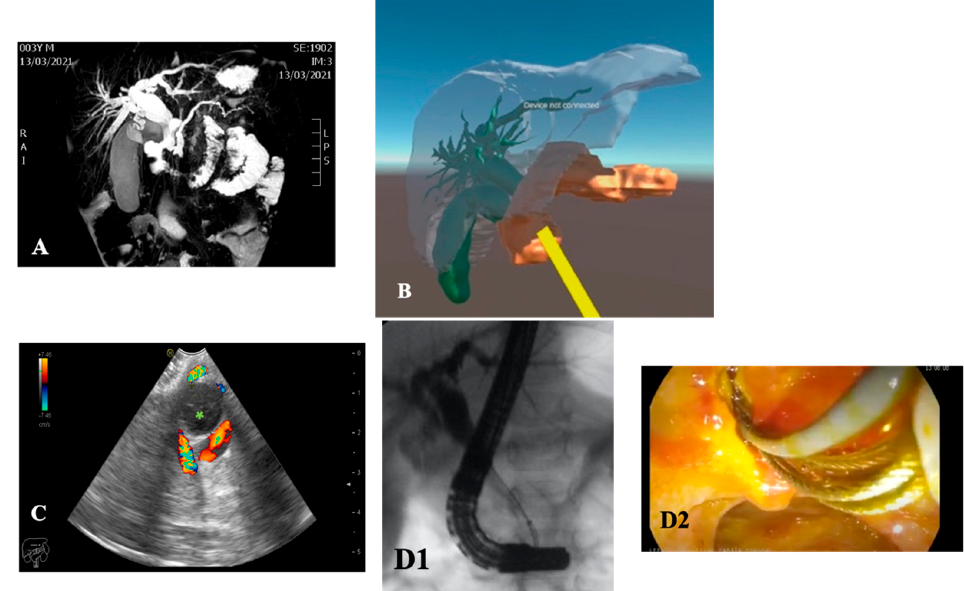
8 of 17 Figure 2. Patient n. 4 underwent surgery in the neonatal period for duodenal atresia. Years later, she developed symptomatic pancreato-biliary tree stones with cholelithiasis and choledocholithiasis. ( A , B ): Cholangio MRI showed a dilated gallbladder (yellow asterisk, ( A )) with stones in the infundibulum and the choledochal channel near a cystic dilatation. ( D – F ): EUS con fi rmed the presence of a dilated gallbladder (yellow asterisk, ( D )). We also identi fi ed a stone in the minor pancreatic duct (yellow arrow, ( F )). ( C ): On the posterior view of the 3D reconstructions, the choledochal channel appears to end in the upper duodenal stump with a dilatation (blue asterisk in ( C )). The pancreatic duct (red arrow in ( C ) ends in the lower duodenal stump. The upper duodenal stump also appears on endoscopic US as a blind-ending pouch (red asterisk in ( C , E )).